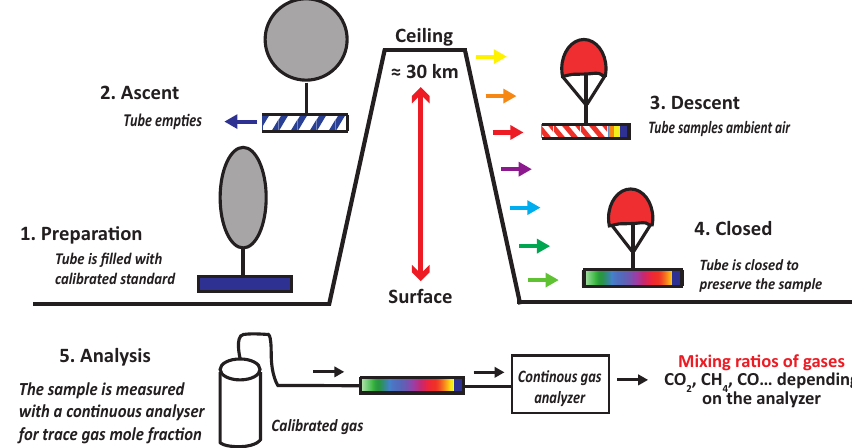
Figure 1. Schematic description of the five steps of the AirCore sampling method.